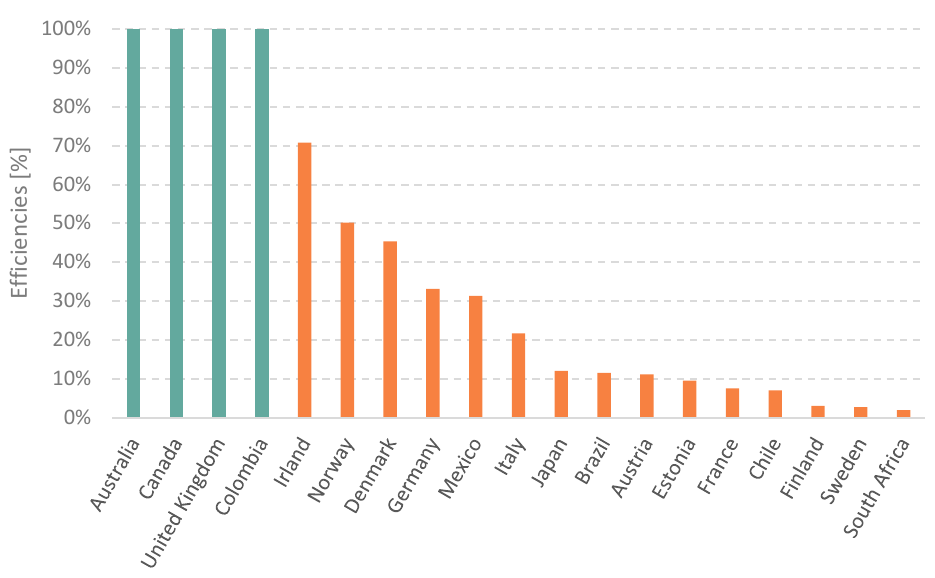
Figure 4. Efficiency ranking—natural gas market. Source: The authors. Note: In green: efficient countries; in orange: inefficient countries.